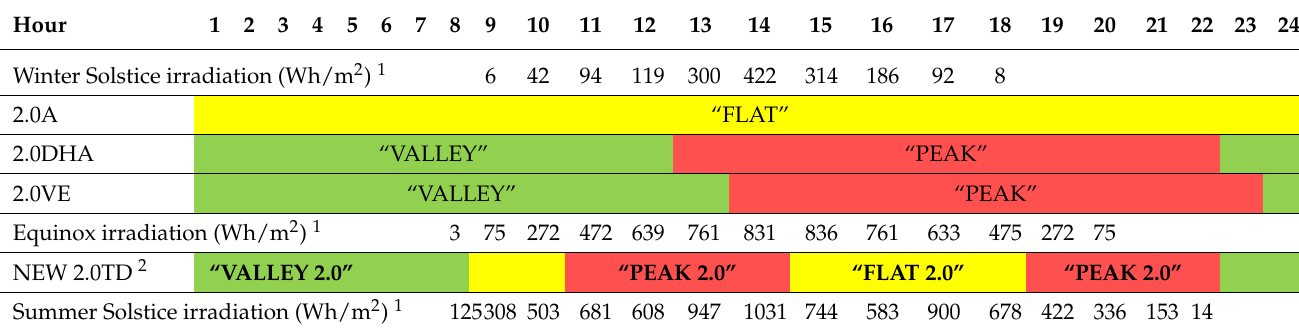
Table 1. Hourly distribution and comparison with horizontal solar irradiation for tariff 2.0.